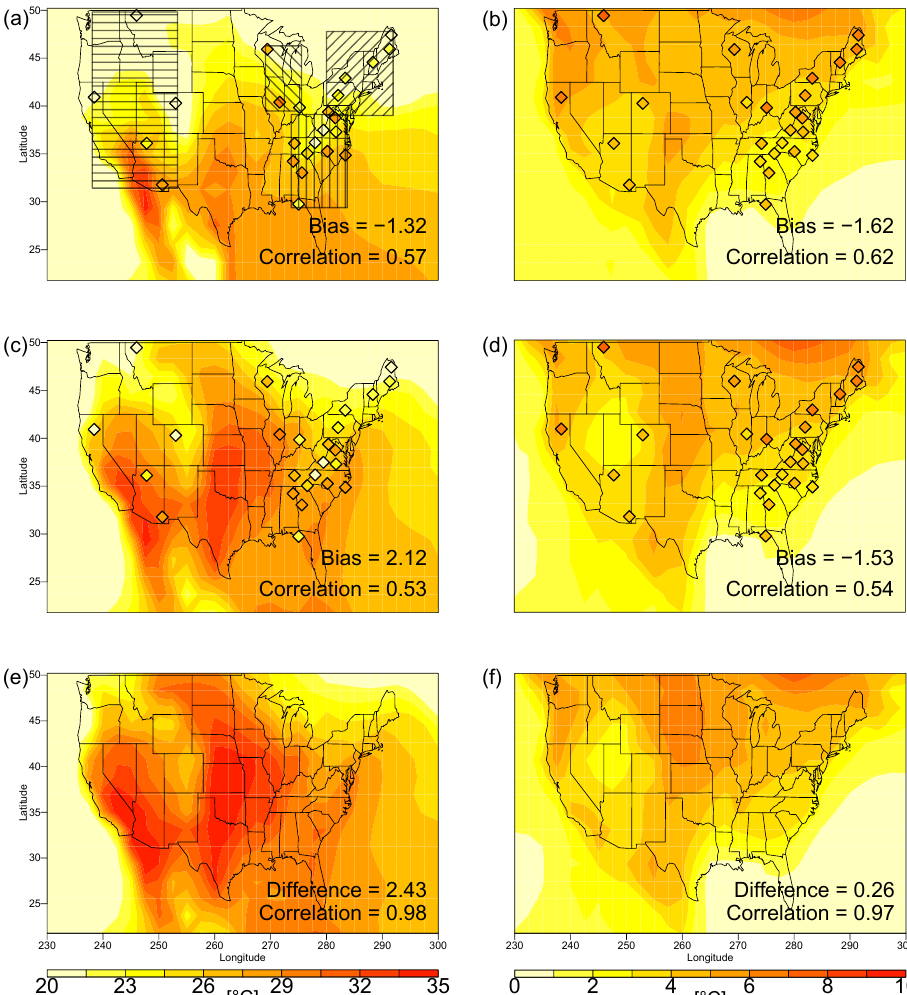
Figure 2. Rescaled data. Average daily maximum temperature ( ◦ C) (a, c, e) , and average daily maximum temperature ( ◦ C) conditioned on maximum temperature greater than the 90th percentile minus average daily maximum temperature (b, d, f) for the CESM1 REFC1SD simulation (1992–2010) (a, b) , the GCM2000 simulation (2006–2025) (c, d) and the GCM2100 simulation (2106–2125) (e, f) . CASTNET measurements (1992–2011) of each quantity are shown as filled diamonds in the first two rows. In the first two rows we also give the average bias as the model average minus the CASTNET average for each quantity, and the correlation as the spatial correlation between the model and the CASTNET measurements. In the last row we give the difference as the mean difference between GCM2100 and GCM2000 over the continental area between 21–51 ◦ N and 230–300 ◦ E and the correlation as the correlation between GCM2100 and GCM2000 over the continental area between 21–51 ◦ N and 230–300 ◦ E. The boxes in (a) show the division of the country into various regions: the northeast, the southeast, the Midwest and the